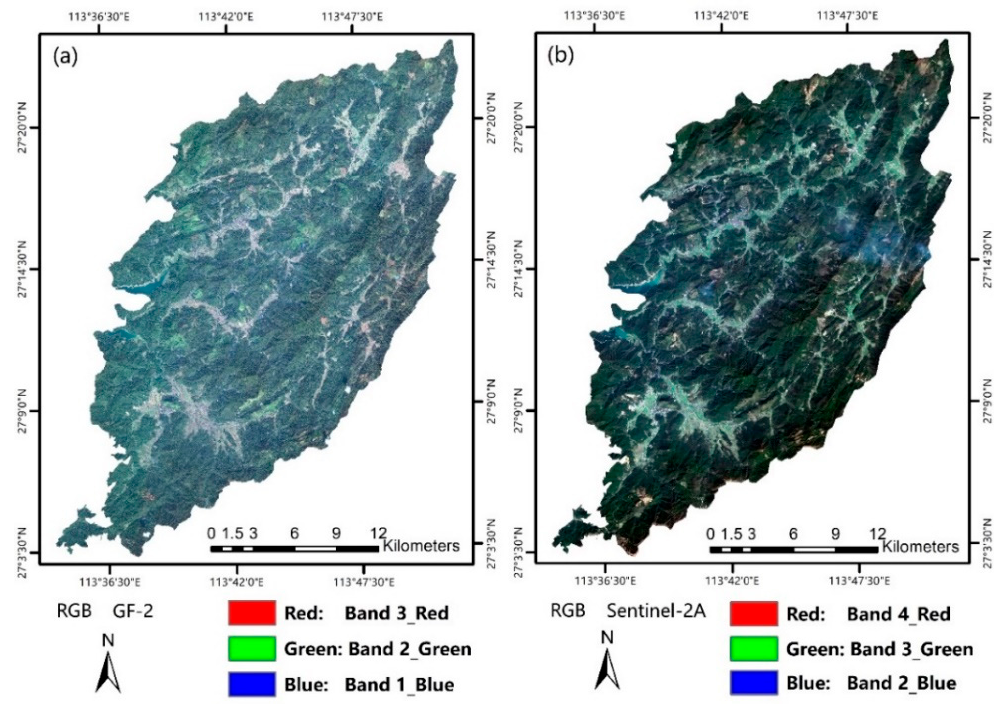
Figure A3. Original GF-2 and Sentinel-2 images. ( a ) RGB true color image of GF-2; ( b ) RGB true color image of Sentinel-2.